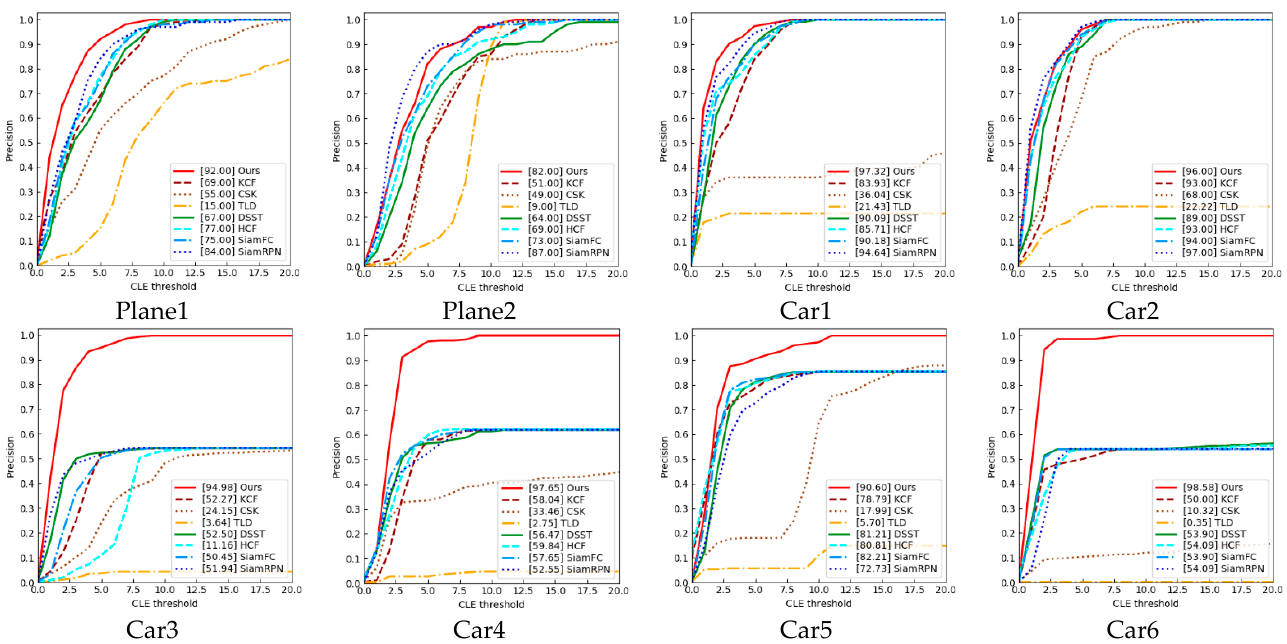
Figure 12. Precision plots of eight video sequences involving object sequences without and with occlusion. The legend in the precision plot is the corresponding precision score per object tracker.